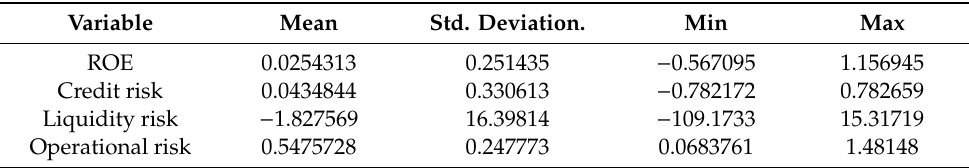
Table 4. Descriptive statistics for the data used in the analysis.